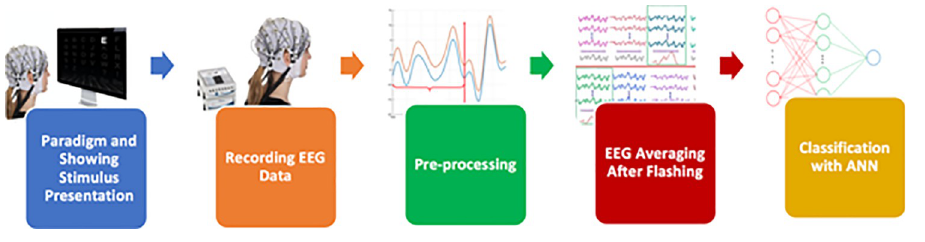
Fig 1. Block-diagram of the proposed BCI system.